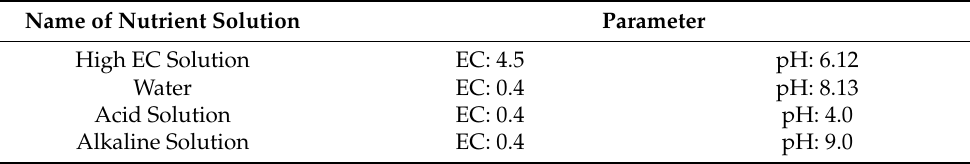
Table 4. Parameter setting of hydroponic nutrient solution.